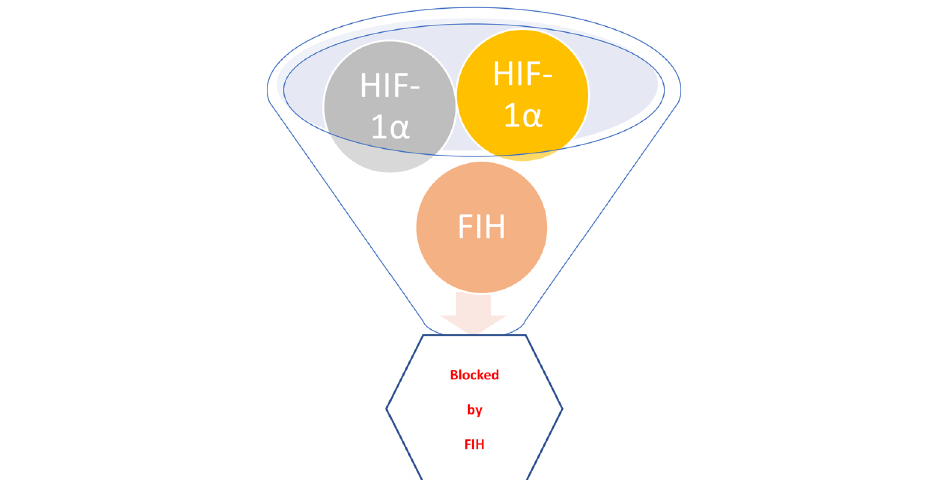
Figure 2. HIF-1 α blockade. In normoxic environments, HIF-1 α is blocked by FIH [15]